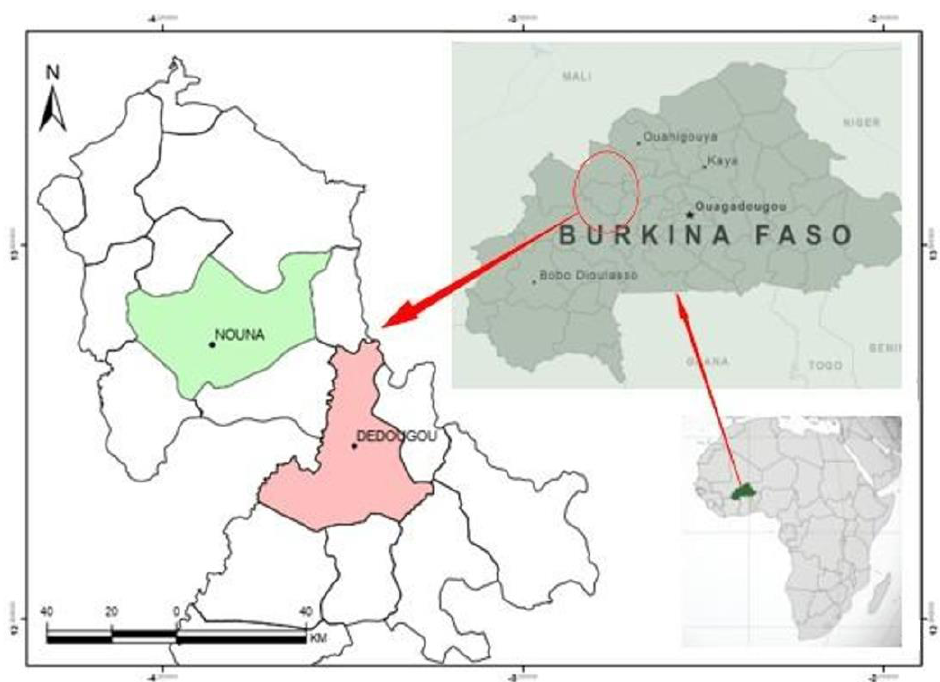
Figure 1. Location of the communes of Nouna and Dedougou.